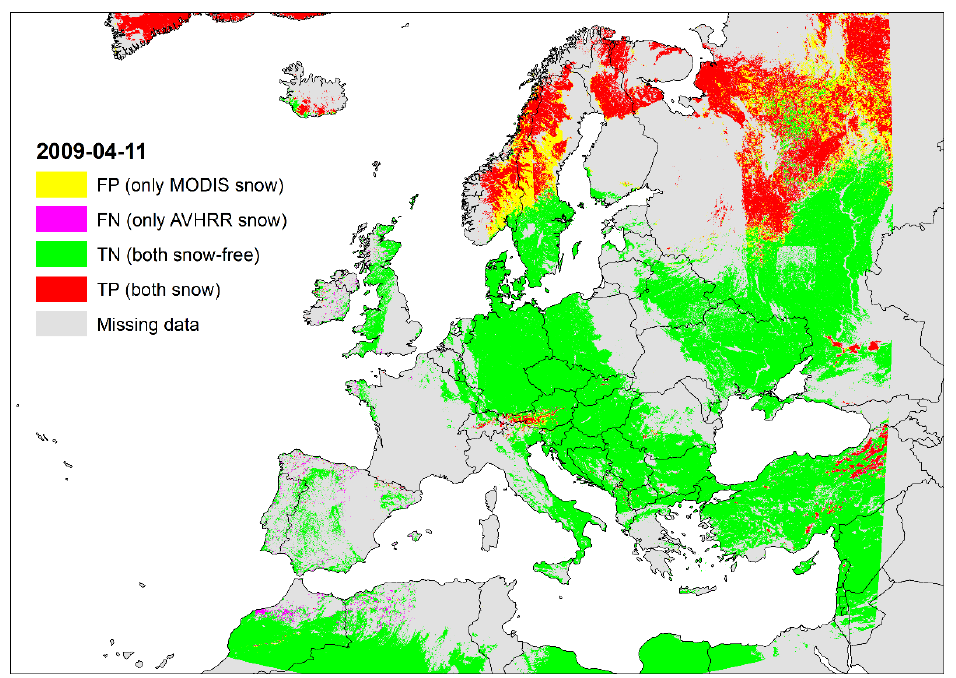
Figure 12. Daily composite of the classification accuracy for 11 April 2009—the date with the best matches between MODIS and AVHRR in terms of PPV (70.54%).